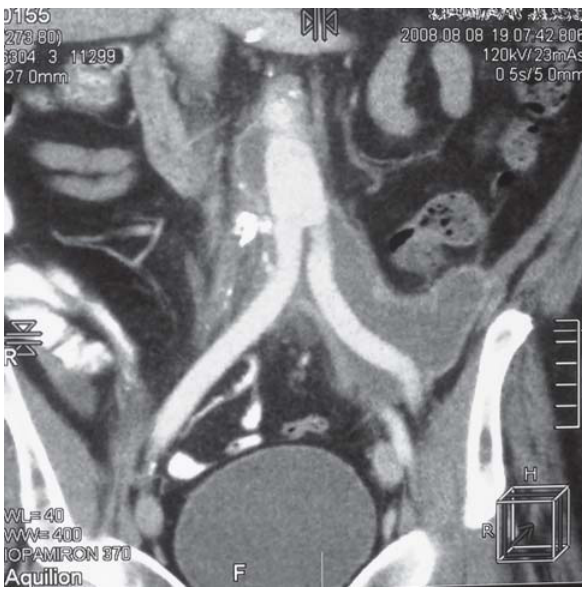
Fig. 2 - Horizontal mattress stitch in the middle of the main body corrugated bovine pericardial tubular graft to make two sides. To each orifice we sutured end to end two